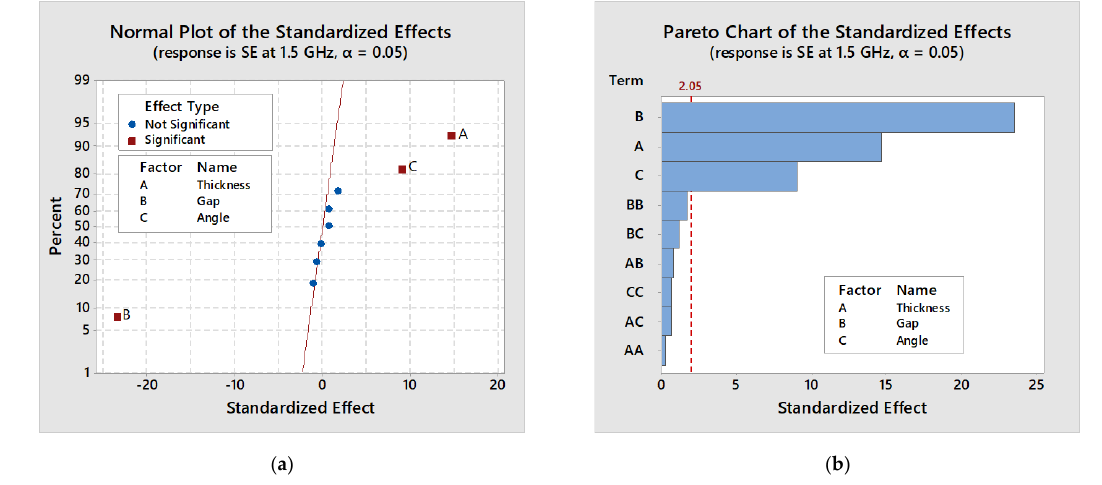
Figure 8. The normal plot of the ( a ) standardized effects and ( b ) standardized Pareto chart.